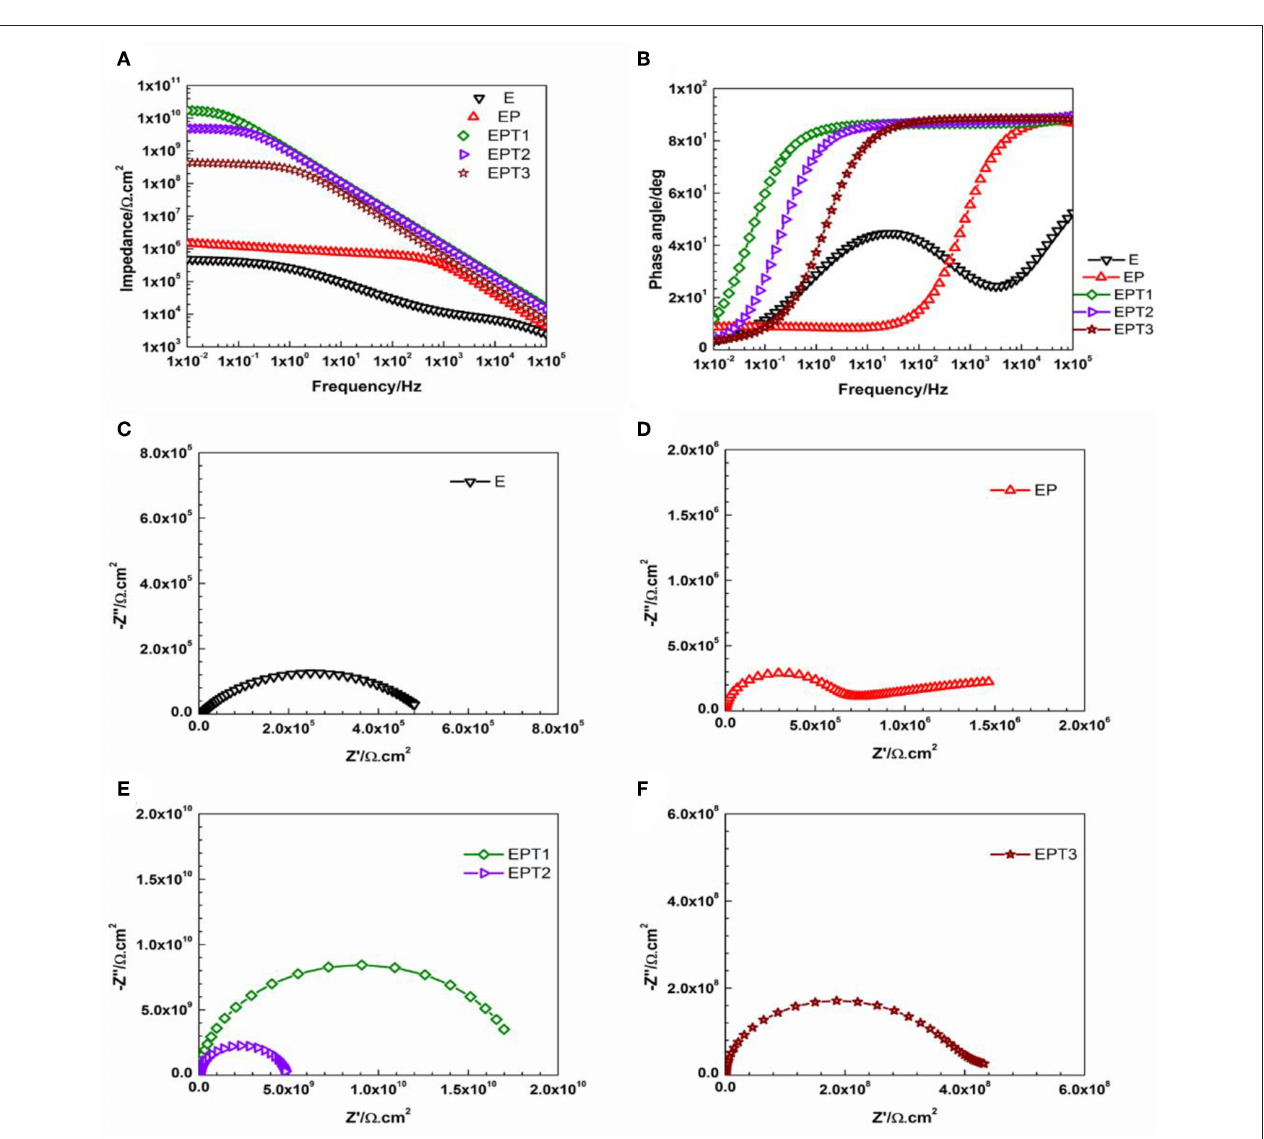
FIGURE 10 | Representative (A) Bode plots and (B) phase angle plots for E, EP, and all PDMS modified epoxy nanocomposite coatings, and Nyquist plots for (C) E, (D) EP, (E) EPT1 and EPT2, (F) EPT3 coating systems after 1 day of immersion.